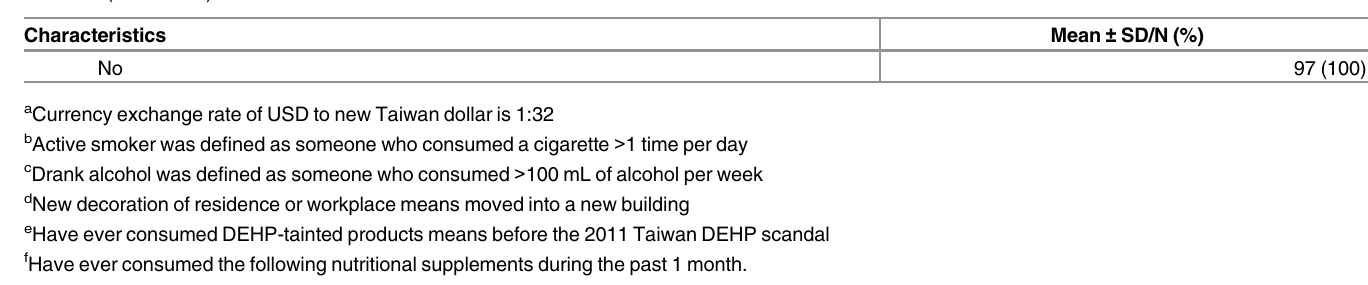
levels for further analysis to avoid potential bias from urinary creatinine. We found that median levels of urinary MBP (MiBP + MnBP), MEHP, MEP, and MMP in our participants (TBC 2013 – 14) decreased 4.8-, 5-, 1.9-, and 2-fold, respectively, compared with those in TBC 2005 – 06 [8], but similar levels were observed for urinary MBzP (Fig 1 and S2 Table). Few phthalate metabolites were detected in amniotic fluid sample (Table 2). The detectable rates of 11 phthalate metabolites in all amniotic fluid samples ranged from 0% to 37.1% (MnBP) and 49.5% (MEHP). We found that only the MEHP and MnBP metabolites were at the 75th percentile (9.62 and 2.53 ng/mL, respectively) and were above the LOD. Thyroid Hormone Level Approximately 90% of the participants ’ thyroid hormone levels for T within reference values for the general population (Table 3). We found the FT the first quartile (0.69 ng/dL) for our participants were below the lowest level for the general population, indicating that around 27% of our participants might have had a mild thyroxine insufficiency (i.e., subclinical hypothyroidism). Table 2. Distribution of creatinine-adjusted levels ( μ g/g creatinine, or ng/ml) of urinary phthalate metabolites in pregnant women (N = 97), and amniotic fluid phthalate metabolites (ng/ml). Phthalate metabolites a Maternal urine Amniotic fl uid Detectable rate (%) Selected percentiles Detectable rate (%) Selected 25th 50th 75th 95th Max 75th 95th Max MMP 69.1 87.6